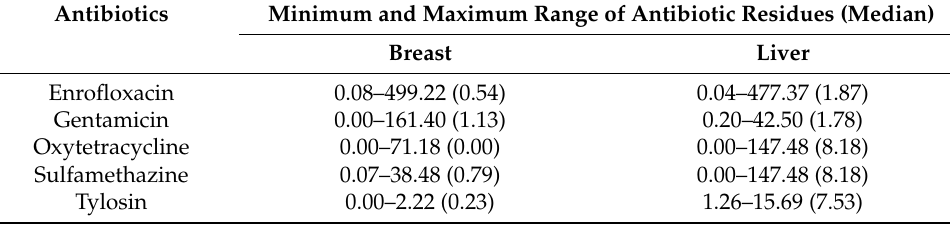
Table 1. Minimum and maximum range with median (in µ g/kg) of different antibiotic residue concentrations in breast and liver of broiler chickens from five farms. Antibiotics Minimum and Maximum Range of Antibiotic Residues (Median) Breast Liver Enrofloxacin